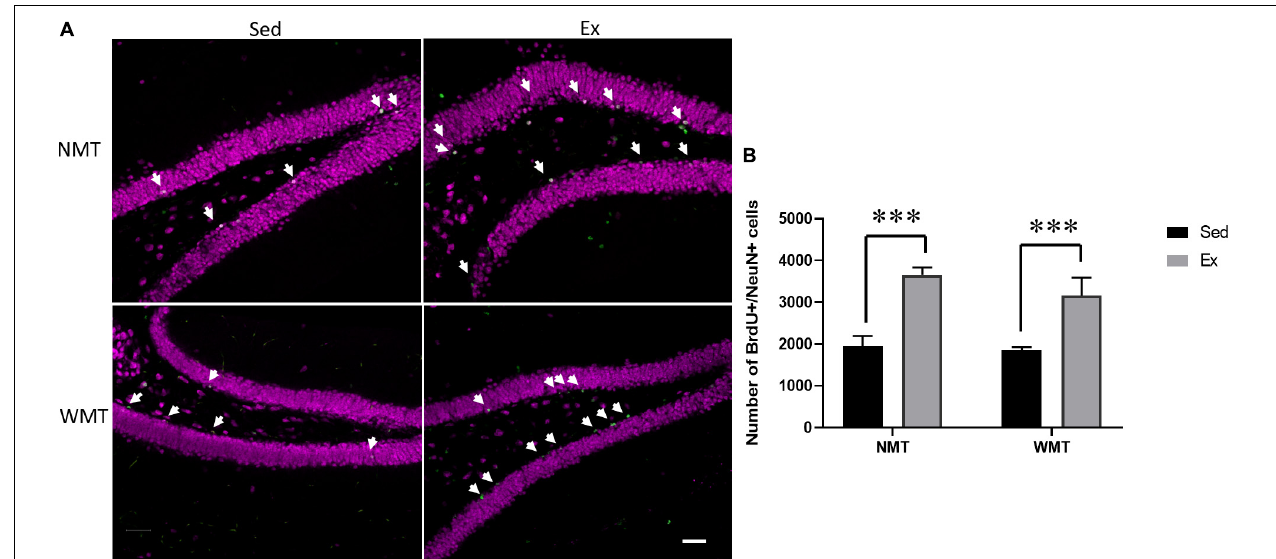
FIGURE 8 | Exercise facilitates adult-born neurons. (A) Representative images of adult-born neurons labeled with 5-bromo-2 (cid:48) -deoxyuridine (BrdU; indicated with arrows) and NeuN in the hippocampal dentate gyrus (DG) of mice in the sedentary (Sed) and exercise (Ex) groups. NMT represents no memory traces; WMT, with memory traces; scale bar, 50 µ m. (B) Four weeks of wheel running enhances neurogenesis in the DG. Data are graphed as means ± SEM (n = 3–4); Data analysis used two-way ANOVA. ∗∗∗ p < 0.001.